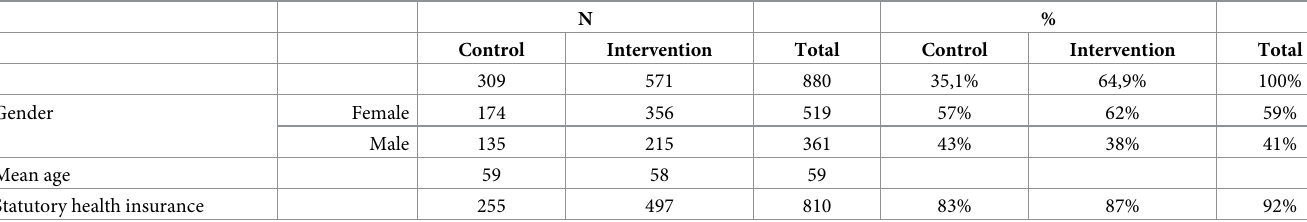
Table 5. Patient cohort characteristics.